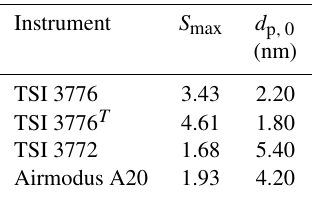
Table 4. Calculated supersaturation ratios: the table shows the re- sults of the modeling of the supersaturation profiles of four different particle counters. The maximum supersaturation ratio is related to the smallest particle diameter necessary for the activation of neutral silver